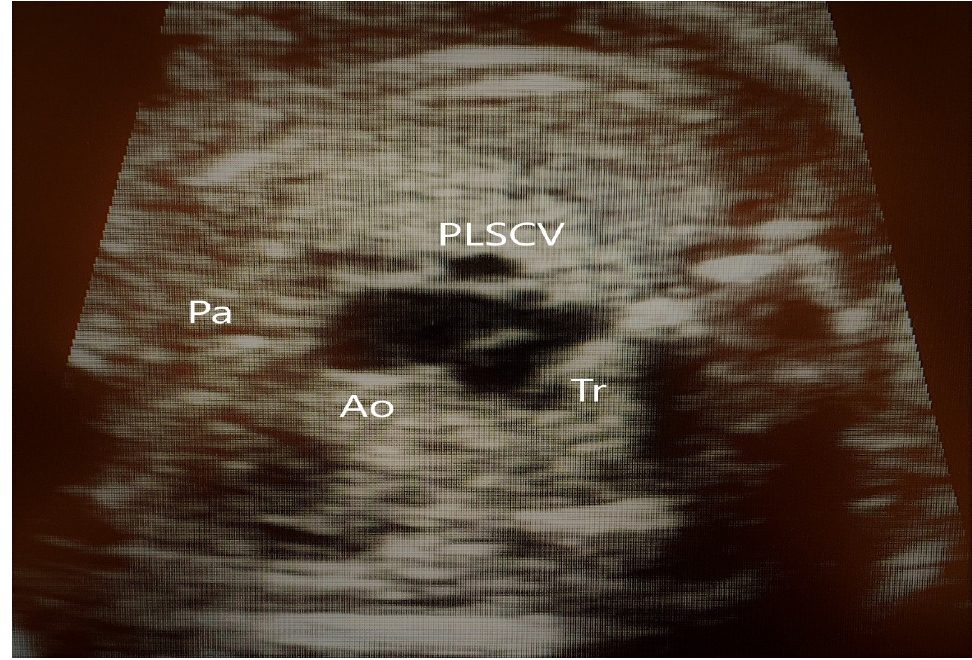
Figure 10. The same case as above; absence of SVC at the TTVV. (PLSVC—persistent left superior vena cava, Ao—Aorta, Pa—Pulmonary artery, Tr—Trachea).